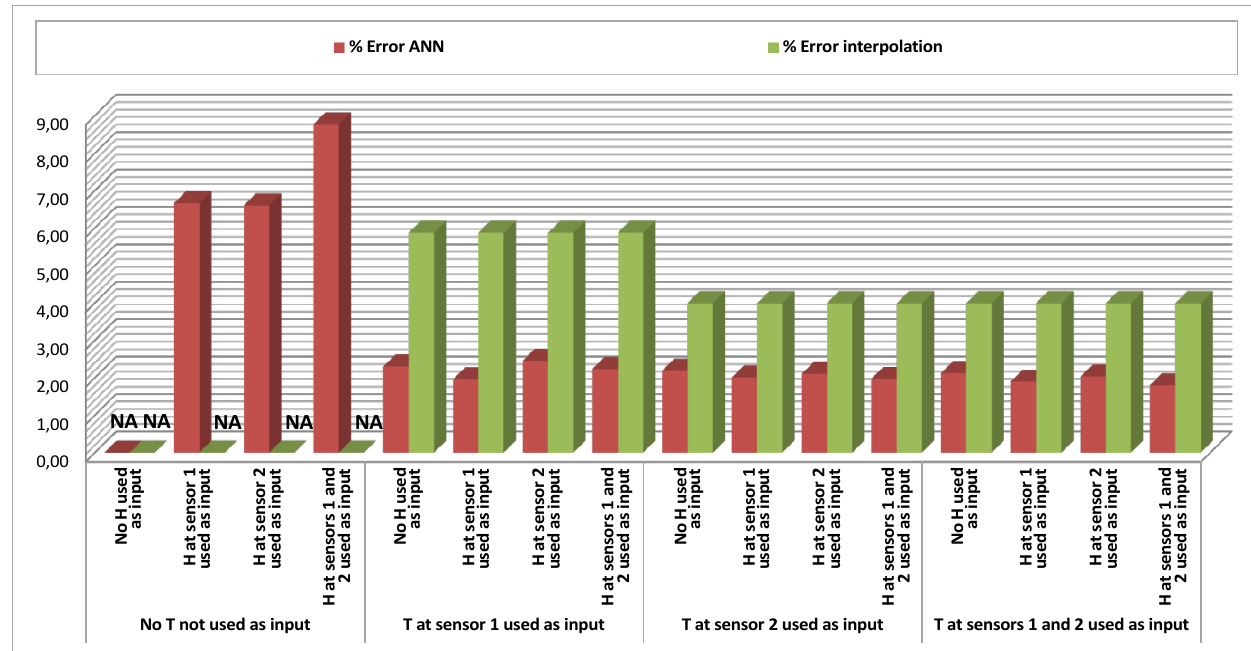
Figure 4. Data Estimation results (% error ANN/% error interpolation) for Temperature (T) in Sensor 3 (S3), combining Temperature (T) and Humidity (H) in Sensors 1 and 2 (S1 and S2) as inputs.